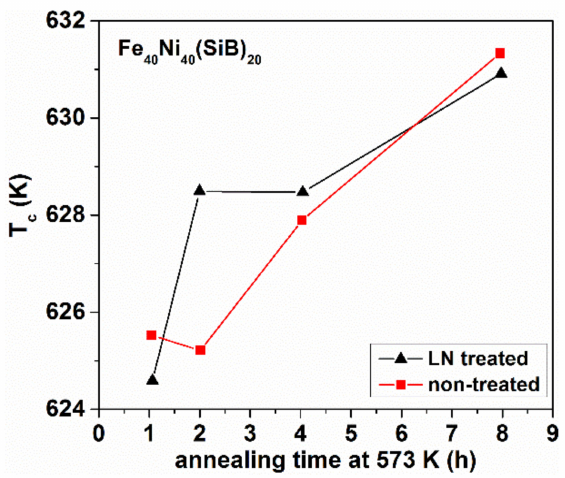
Figure 23. Change of the Curie temperature T Cam after isothermal heat treatment at 573 K for LN treated and non-treated samples. Adopted from [98], with permission from IEEE, 2010.